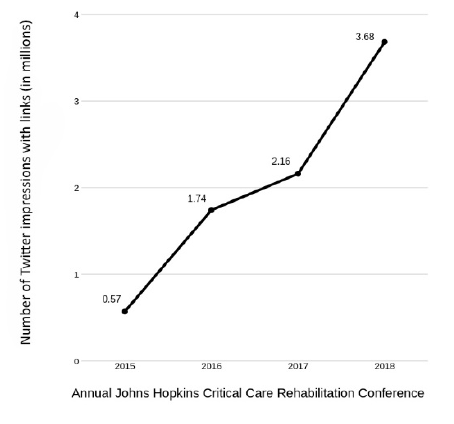
Figure 2 Number of impressions for tweets with links